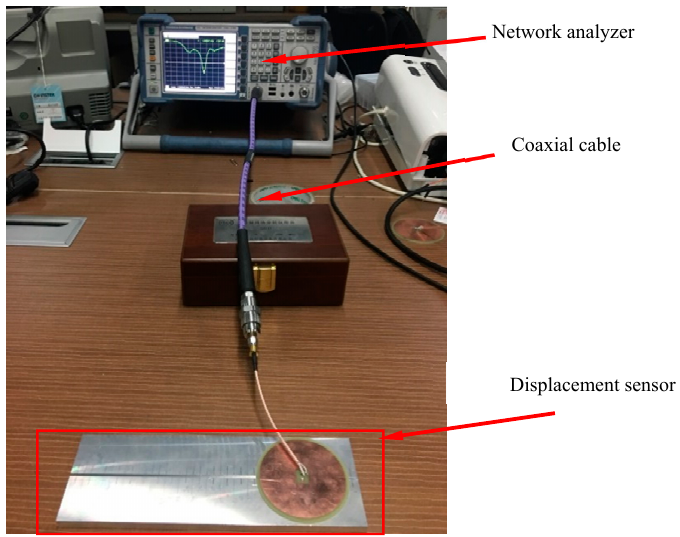
Figure 11. Measuring resonant frequency by using Vector Network Analyzer.